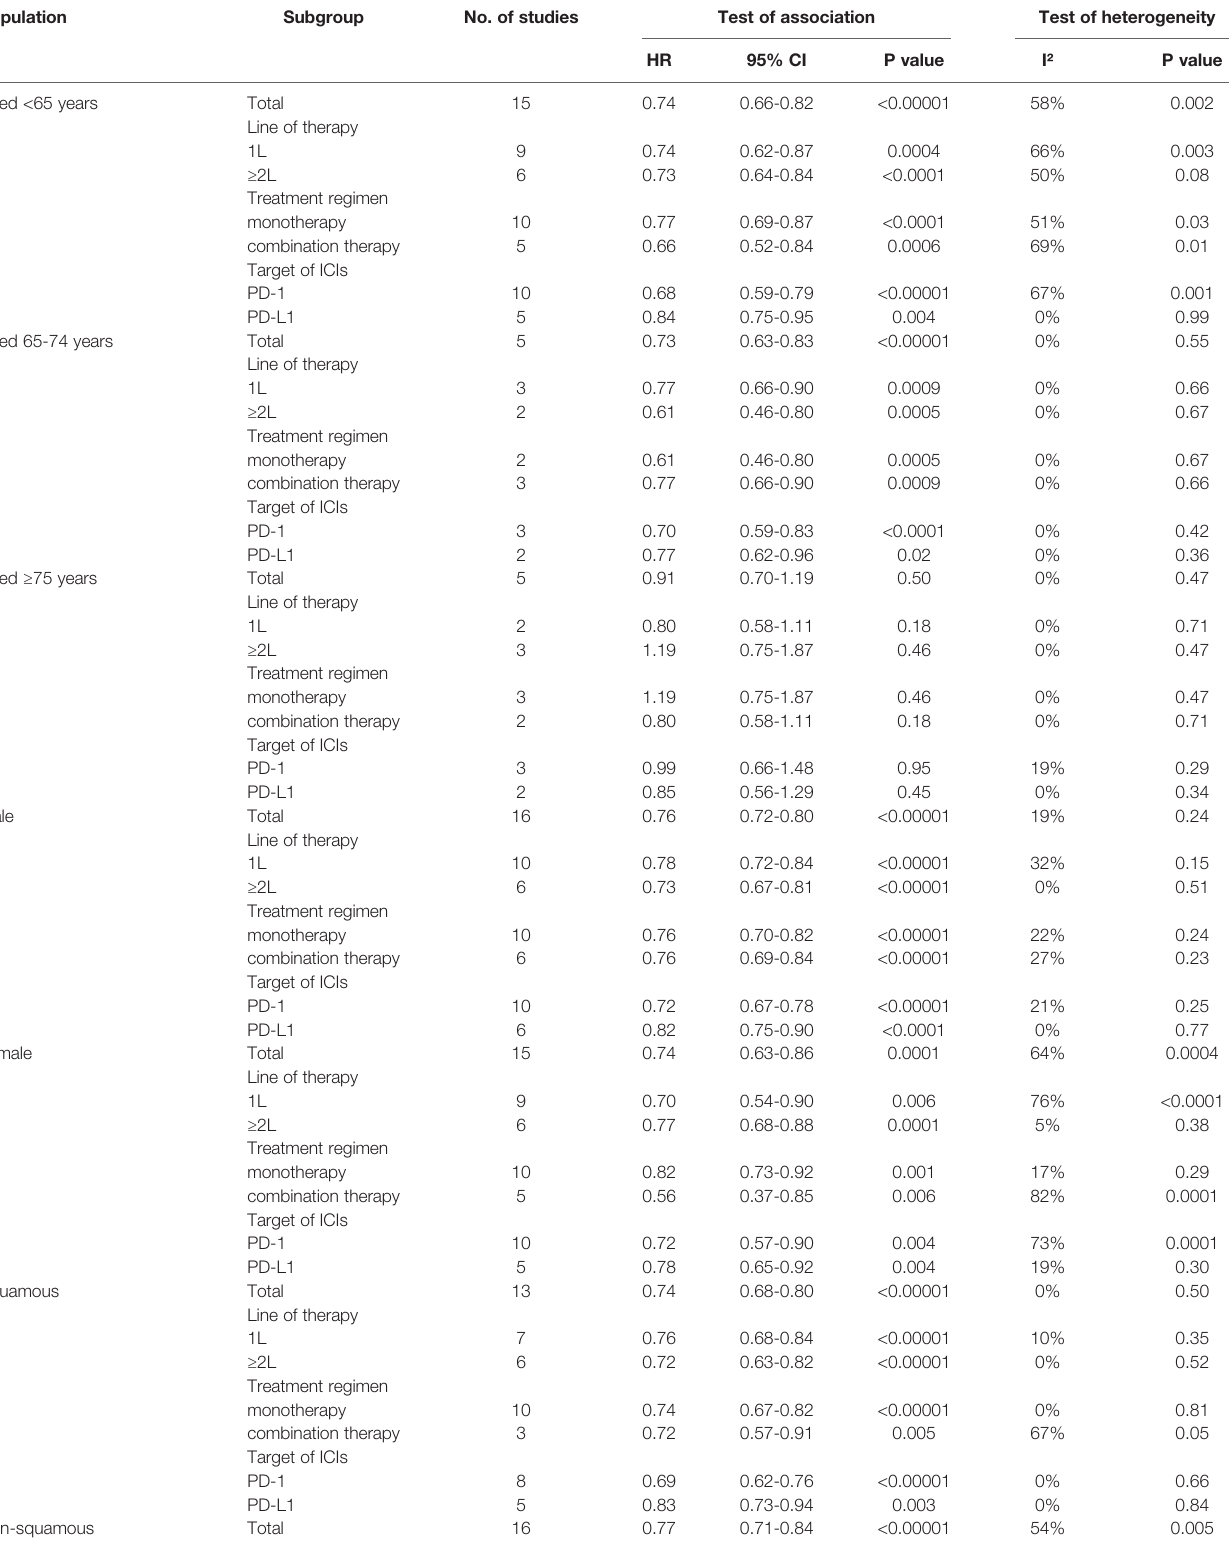
TABLE 2 | Subgroup analysis comparing OS in patients with different clinical and molecular characteristics.